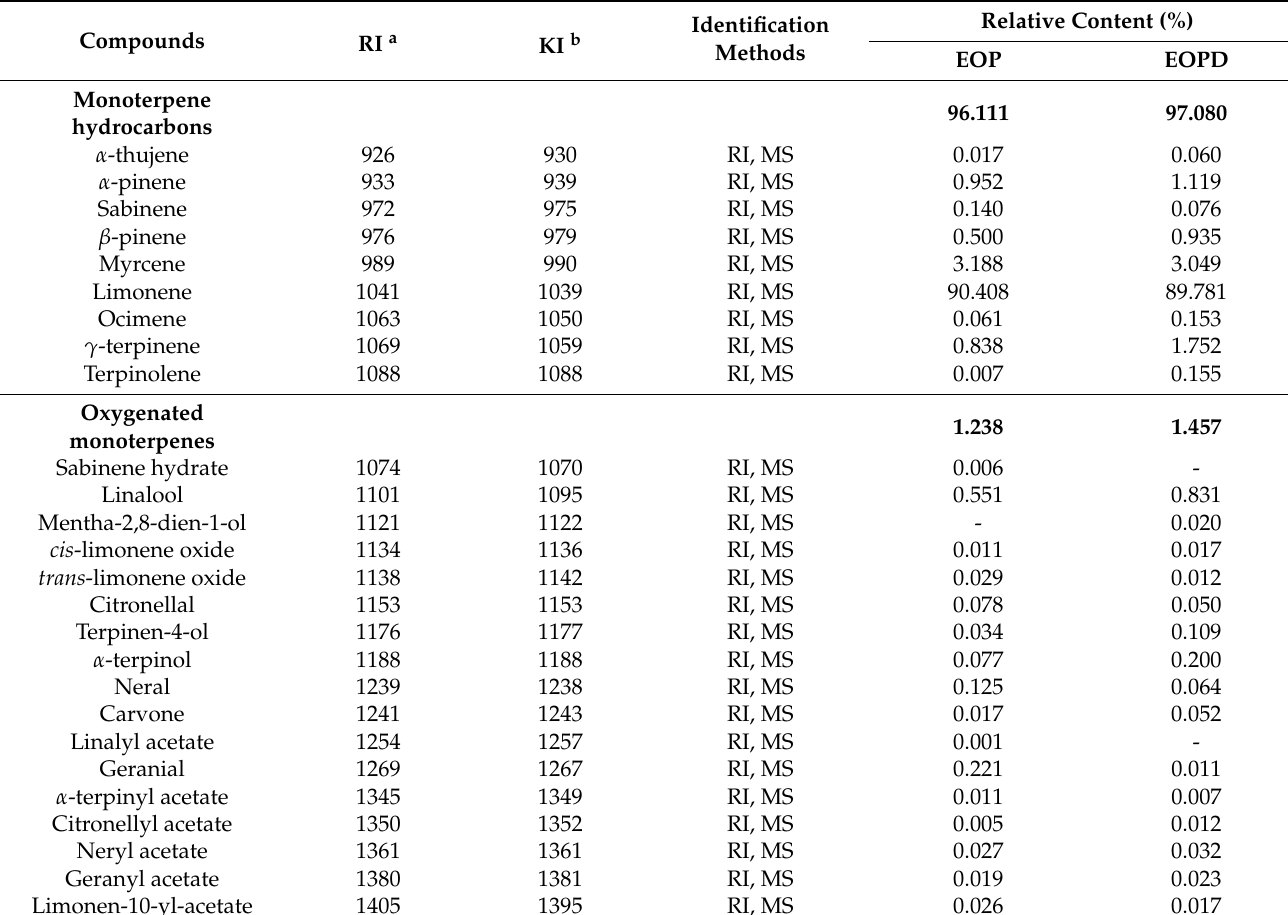
Figure 2. GC chromatogram of the sesquiterpene fractions of orange essential oil obtained using the cold-pressed method (EOP). Table 1. Chemical constituents of essential oils obtained from fruit peels of Citrus sinensis (L.) Osbeck (Rutaceae).